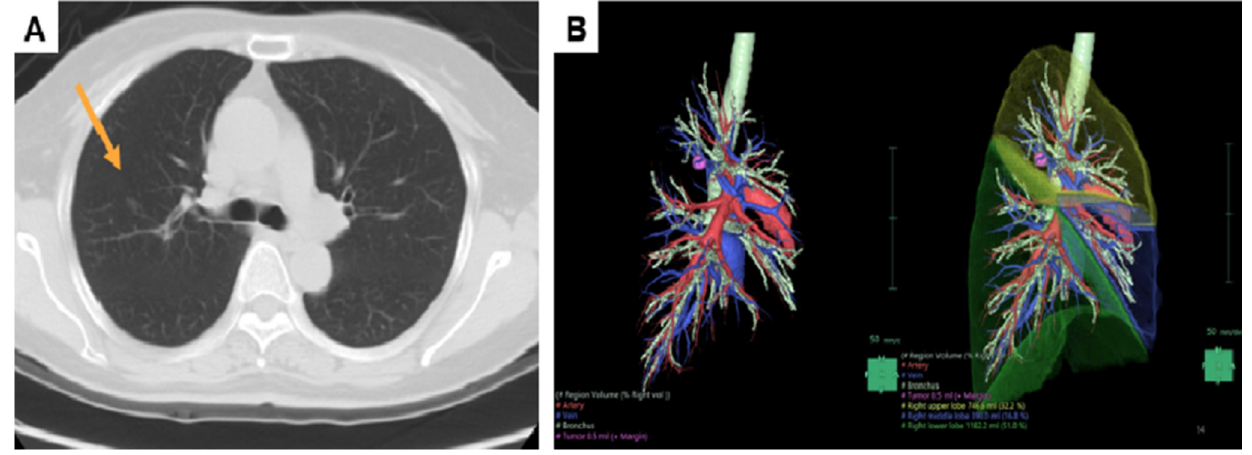
Figure 1. Characteristics of the lesion. ( A ) A deeply located lesion (arrow) over right upper lobe S2– S3 junction ( B ) 3D reconstruction of the lesion.